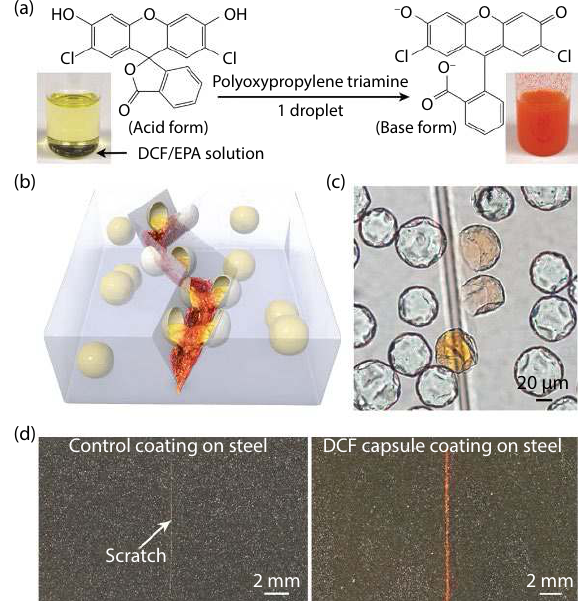
Fig. 13 A pH-induced self-reporting polymeric coating for mechanical damage indication. ( a ) DCF color change indicating mechanism. ( b ) Schem- atic of autonomous damage indication concept. ( c ) Optical images of micro- capsules immersed in curing agent. Color develops when the core materials are released by rupture of the capsule shell wall. ( d ) Optical image of control epoxy coating with no capsules (left) and epoxy coating with 10 wt. % DCF micro- capsules (right) on steel substrates with identical scratches. Reproduced with permission from ref. [191], © 2016 WILEY ‐VCH Verlag GmbH &